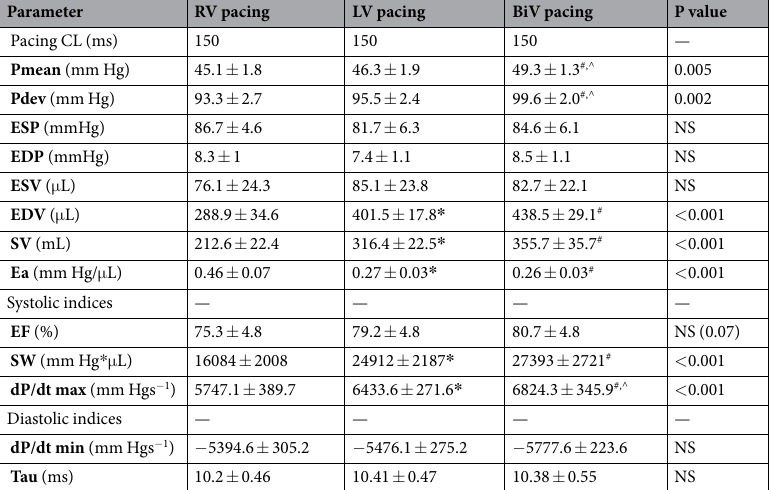
Table 2. PV loop analysis of rats implanted with RV and LV pacing electrodes. Repeated P-V loop measurements in rats under RV, LV and BiV pacing modes (n = 8 for all). Statistical analysis was done using repeated measure one way ANOVA. Symbols indicate significant difference in post-test analysis; * LV vs. RV, # BiV vs. RV, ^ BiV vs. LV. Pmean = mean pressure; Pdev = developed pressure; ESP -end systolic pressure; EDP -end diastolic pressure; ESV = end systolic volume; EDV = end diastolic volume; SV = stroke volume; Ea = arterial elastance; EF = ejection fraction SW = stroke